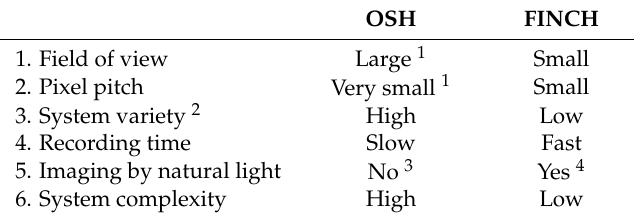
Table 1. Comparison of optical scanning holography (OSH) and Fresnel incoherent correlation holography